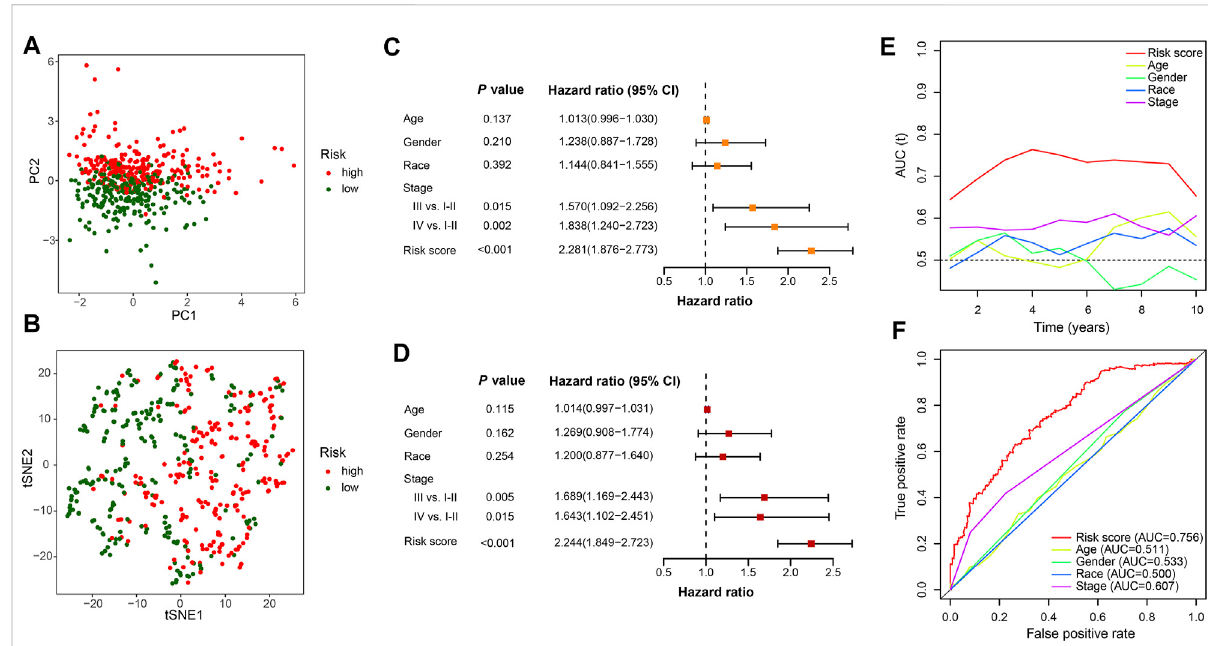
FIGURE 4 Evaluation of the ferroptosis-related lncRNAs signature (FerRLSig) in the entire set of TCGA-LUSC; (A) Principal component analysis of TCGA- LUSC RNA sequencing annotated with the FerRLSig strati fi cation; (B) t-distributed stochastic neighbor embedding (t-SNE) analysis annotated with the FerRLSig strati fi cation; (C) Univariate Cox regression overall survival analysis of the FerRLSig score and universal clinical characteristics; (D) Multivariate Cox regression overall survival analysis of the FerRLSig score and universal clinical characteristics; (E) Time-dependent area under curve plot of the risk score and clinical characteristics. (F) Receiver operating characteristic (ROC) curves of the universal clinical characteristics and risk score of the 5-years overall survival.